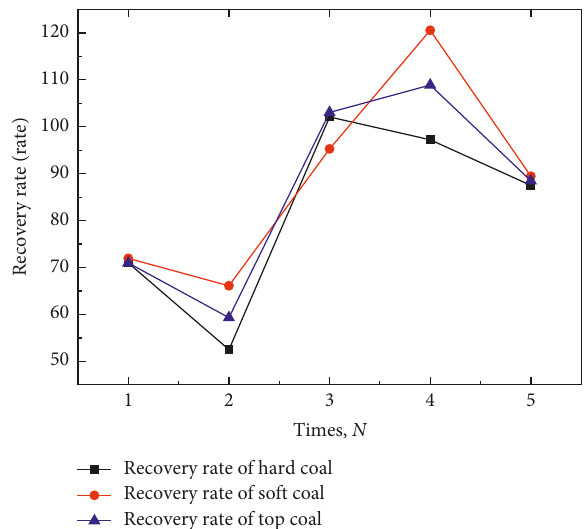
Figure 20: Top coal recovery rates and containing vermiculite rate of three knife one